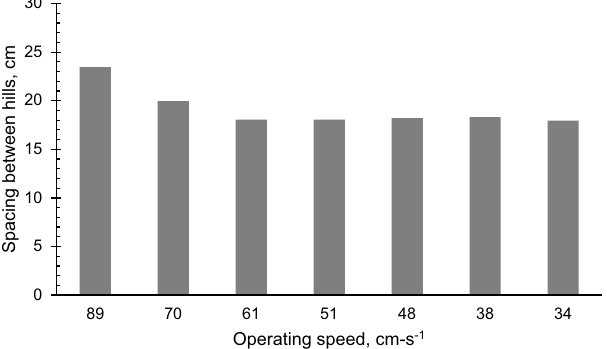
Figure 10. The influence of the different levels operating speeds (cm s −1 ) on the spacing between hills of deposited carrot seeds by the carrot seeder along the